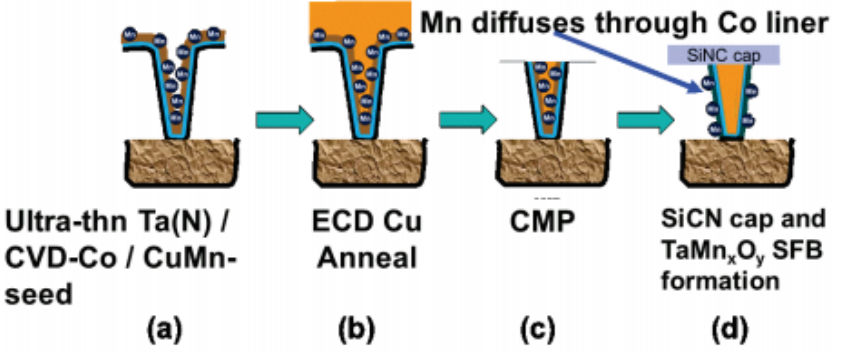
Figure 8. Through Co self-forming barrier (tCoSFB) structure and fabrication process. ( a ) an ultra- thin Ta(N)/CVD-Co film stack is formed on the patterned ULK pSiCOH surfaces, followed by a high-Mn% PVD-Cu(Mn) seed layer. ( b ) Cu electroplating and post-plating anneal. ( c ) CMP. ( d ) a PECVD SiCN(H) dielectric cap is deposited. Reprinted/adapted with permission from Ref. [63]. 2015, IEEE.